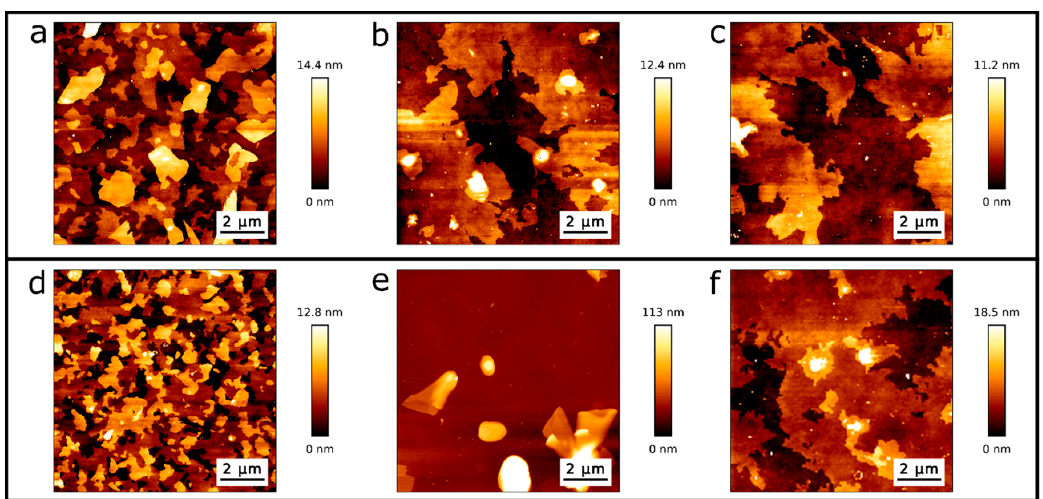
Figure 6. AFM topography images of the DPPC bilayer taken at RT in air during consecutive measurements in the same scan region (2 µm × 2 µm) to induce the reduction of the island-like DPPC bilayer surface area, applying two different tip forces, ( a – c ): 1 nN; ( d – f ): 3 nN.